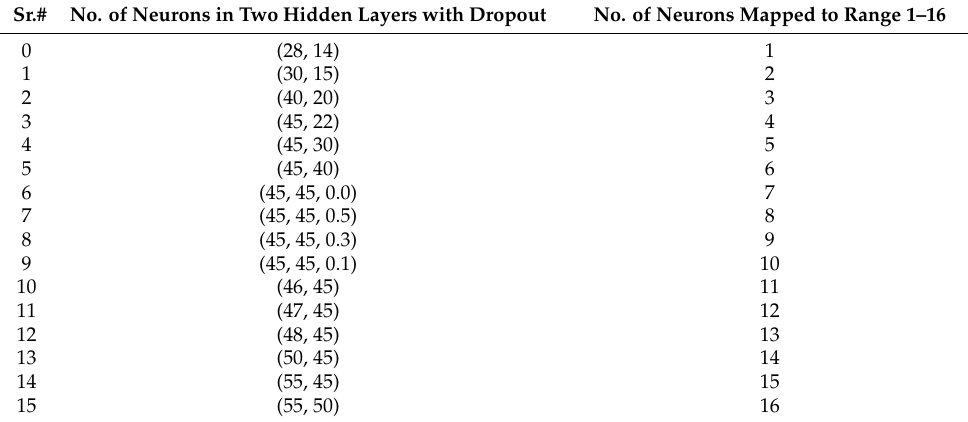
Table 2. Mapping of the dense